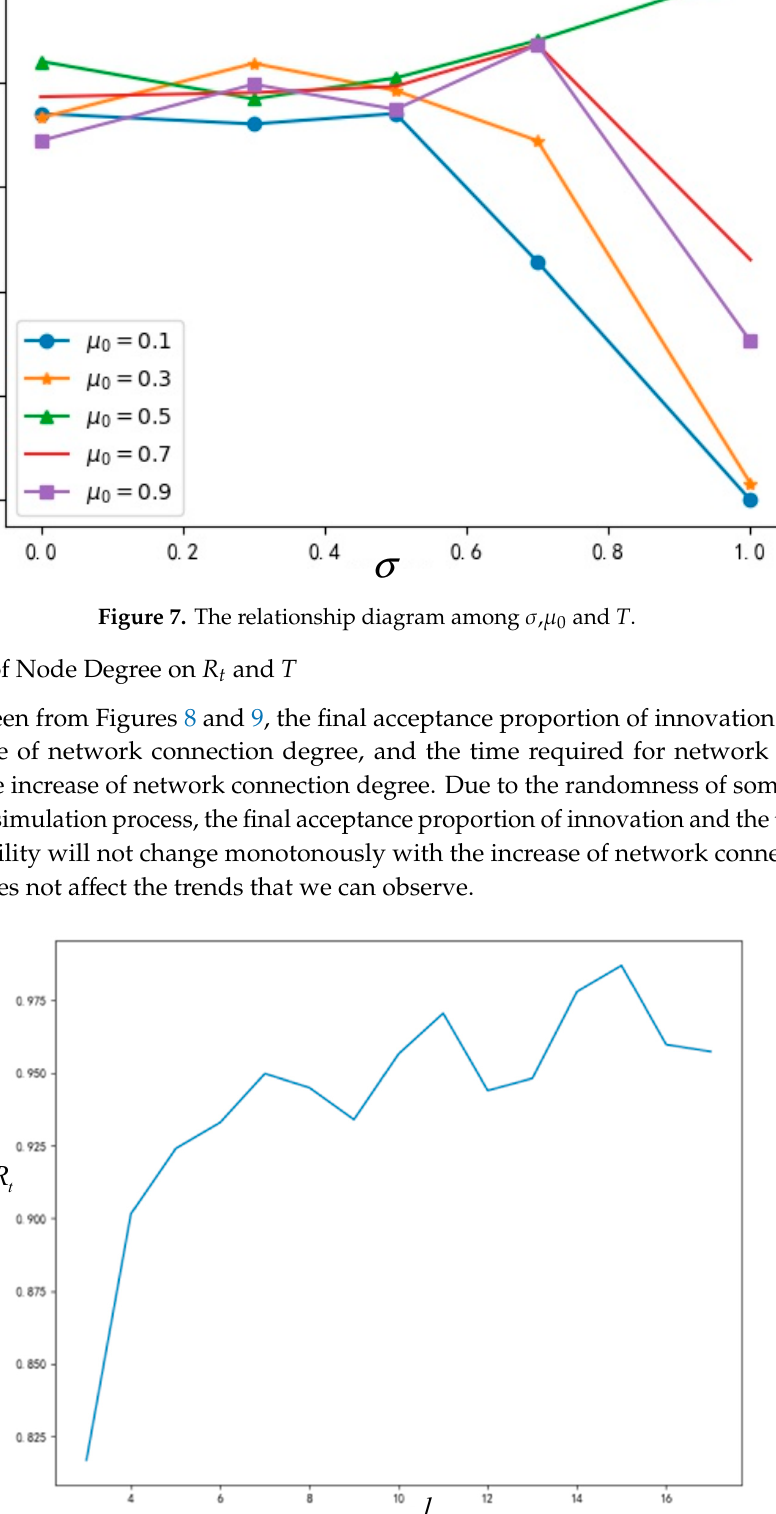
Figure 8. The relationship between node degree and R t